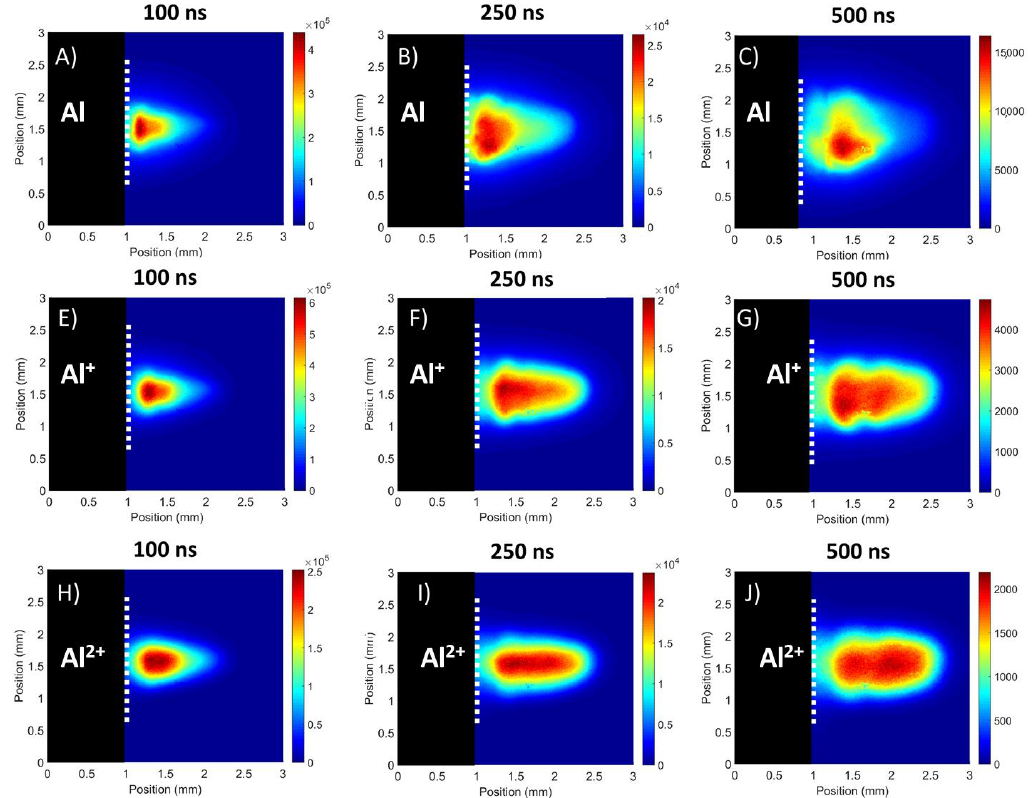
Figure 6. Spectrally filtered images ( A – J ) of the flat target showing the di ff erent distributions of the Al, Al + and Al 2 + species for three time delays.